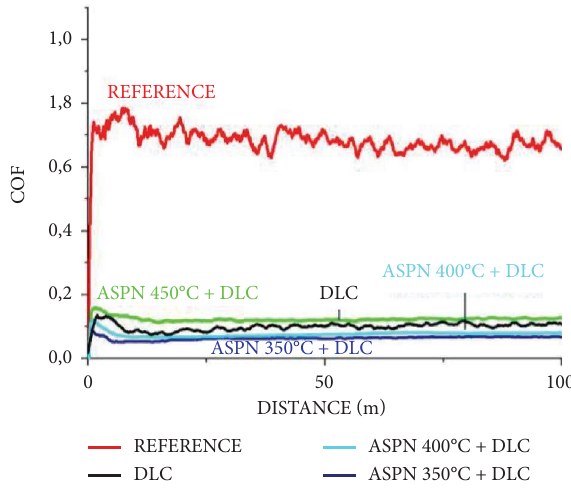
Figure 8: Friction coefcients of DLC sample (black plot), ASPN 450 ° C +WC: C coating (green plot), ASPN 400 ° C+WC :C coating (light blue plot), ASPN 350 ° C +WC:C coating (dark blue plot), and reference AISI316-L (green